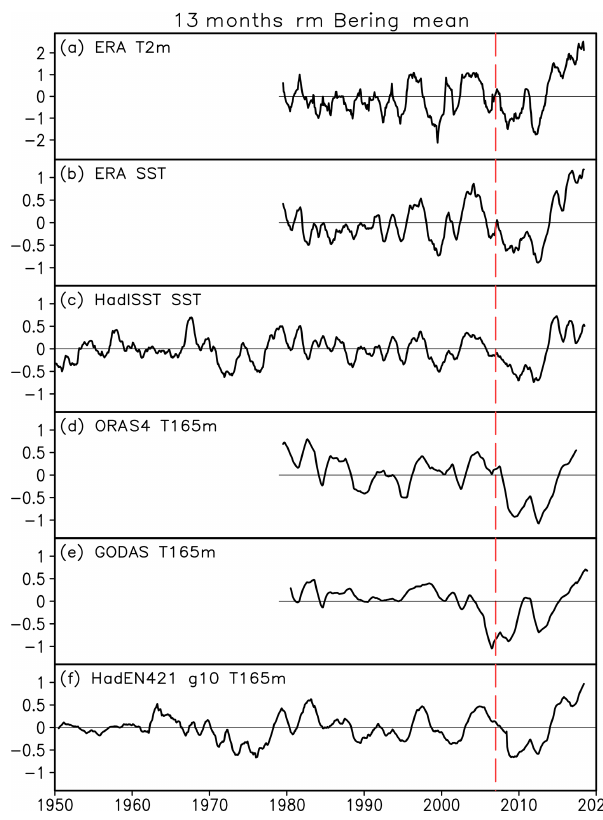
Figure 5. Time series of Bering-mean temperature anomalies from various datasets. (a) ERA-Interim 2m air temperature; (b) ERA- Interim sea surface temperature; (c) HadISST1 sea surface tem- perature (with the global mean SST subtracted from the original data); (d, e, f) subsurface (165m) temperature from ORAS4, GO- DAS and HadEN4.2.1 g10 datasets. All data are low-pass filtered by 13-month running means. The dashed red line marks the critical year of